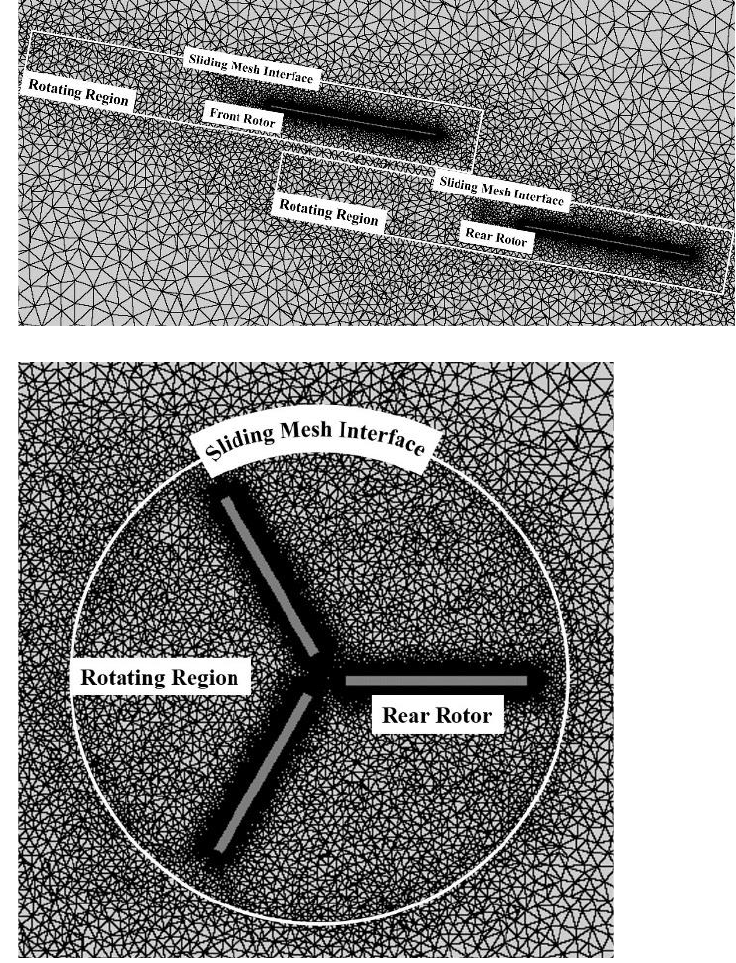
Figure 12. Grid layout and sliding mesh interface.